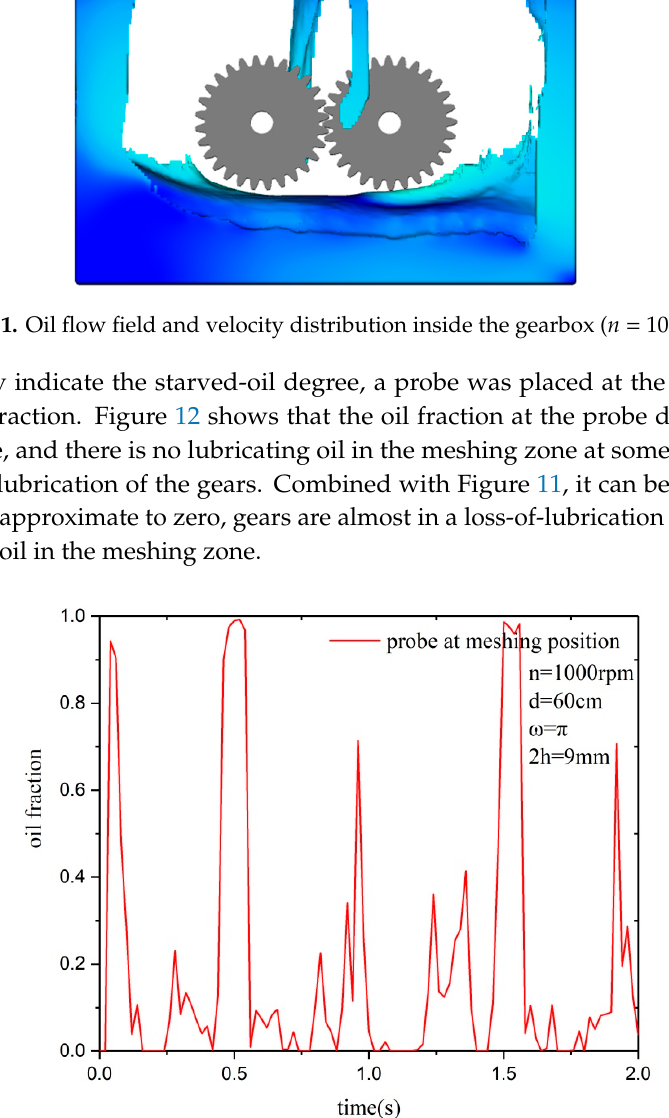
Figure 12. Oil fraction of the probe at the gear meshing zone.